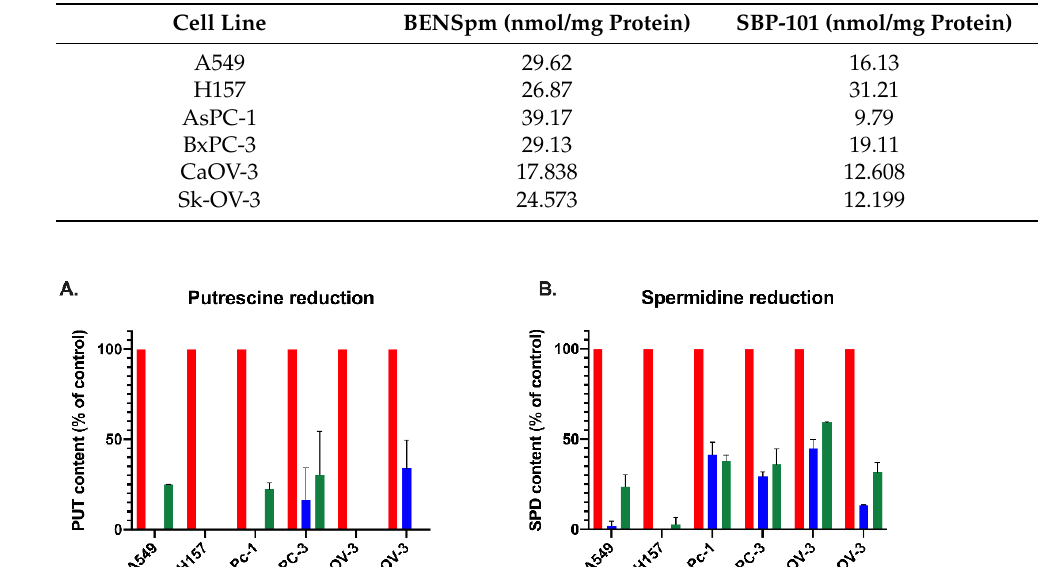
Table 2. Intracellular analogue concentrations following treatment.